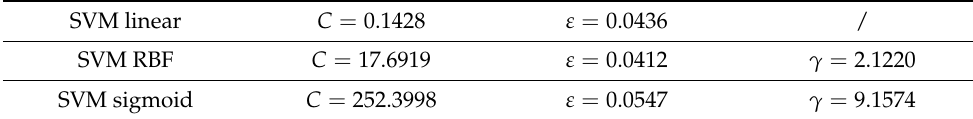
Table 6. Values of optimal kernel function parameters in the SVM method. SVM linear C = 0.1428 ε = 0.0436 / SVM RBF C = 17.6919 ε = 0.0412 γ = 2.1220 SVM sigmoid C = 252.3998 ε = 0.0547 γ =